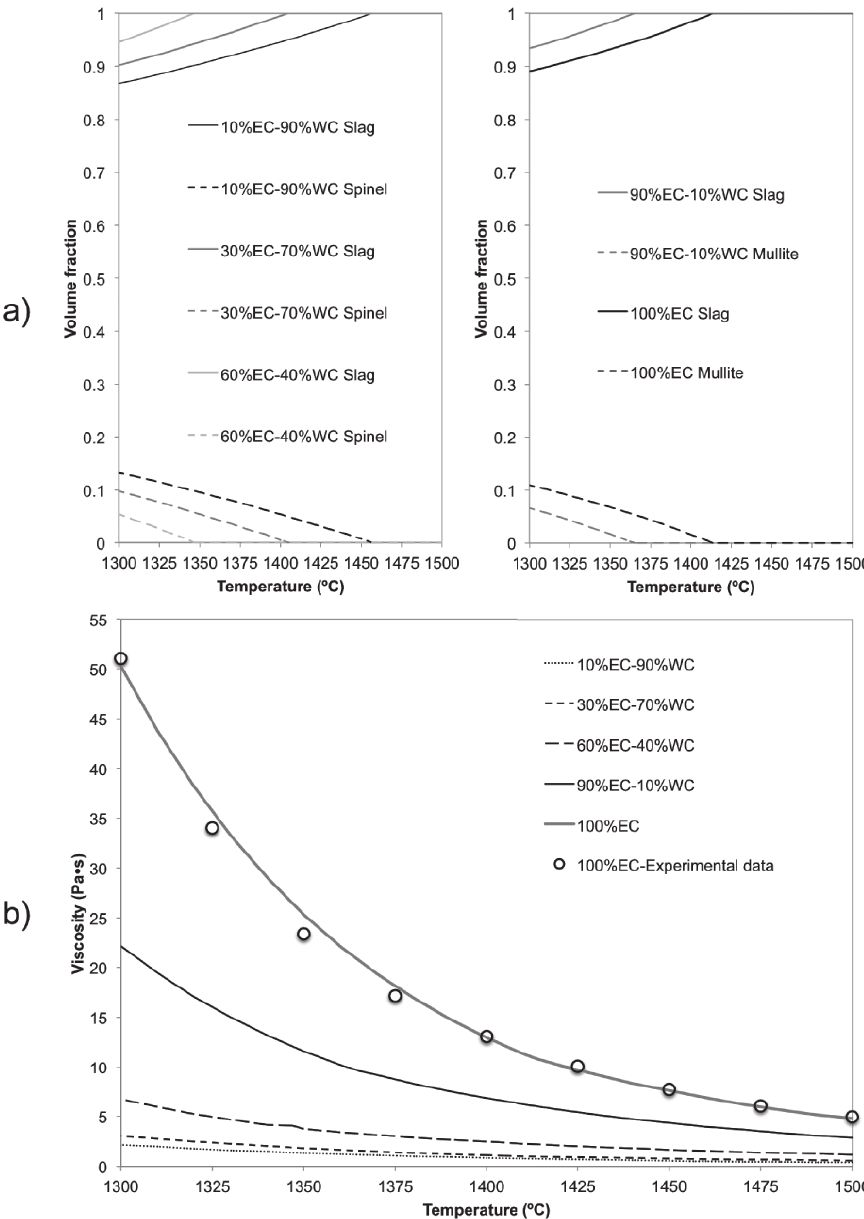
Fig. 8: (a) The solid volume fraction in eastern and western coal blends (mass%) on an ash basis (without considering ZrO 2 .) calculated with FactSage. (b) Predicted viscosity of slag blends with Veytsman model and using solids fractions in figure